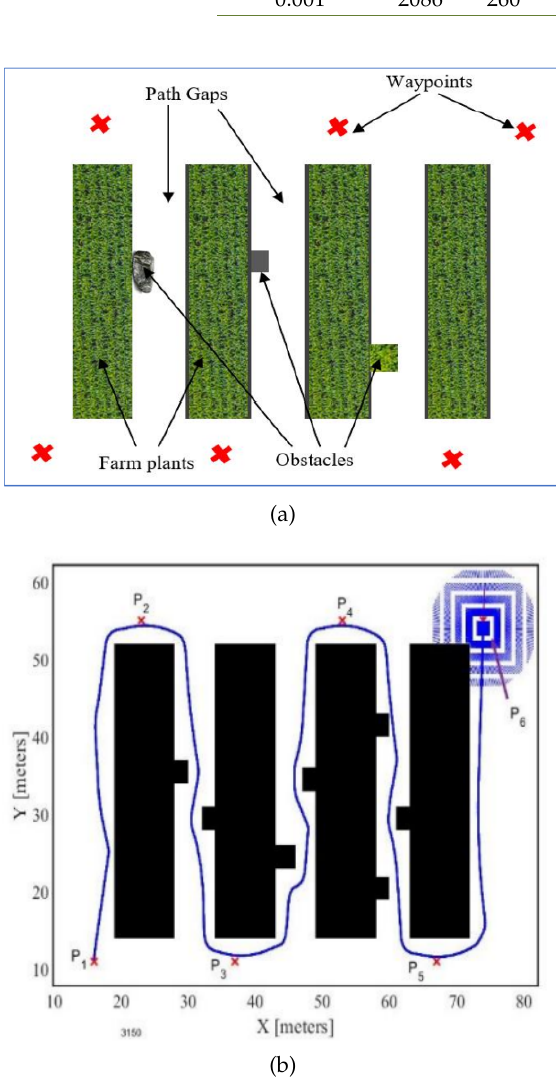
Fig. 2. (a) Real field image scenario. (b) field image with grid occupancy map.